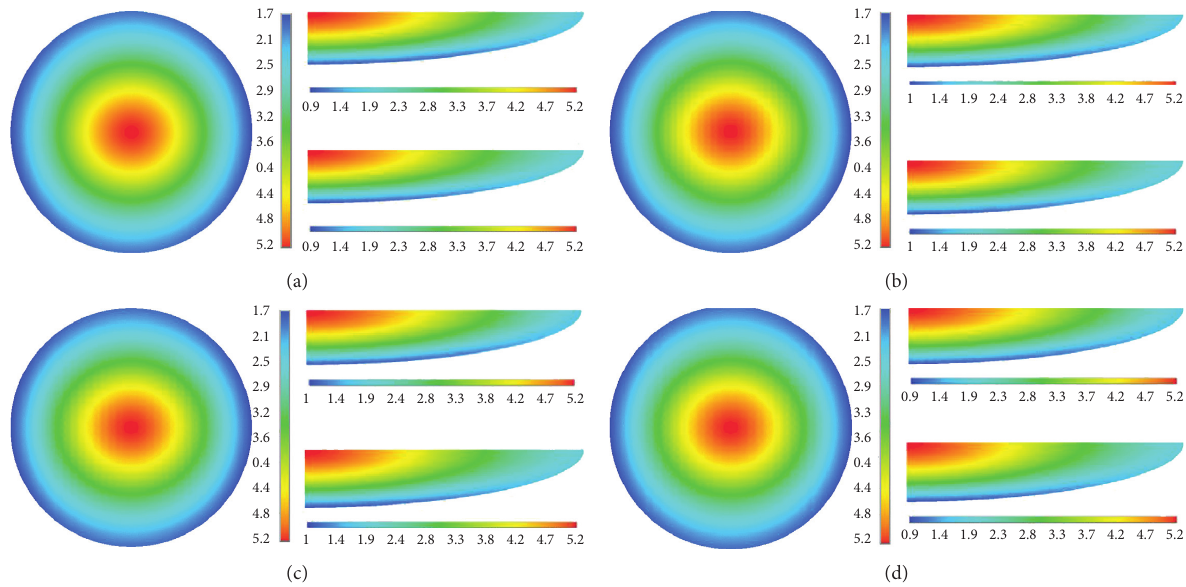
Figure 12: The displacement amplitude of the homogeneous sedimentary basin ( f � 0.5Hz): (a) no buildings; (b) D � 55m; (c) D � 62.5m; (d) D � 70 m.